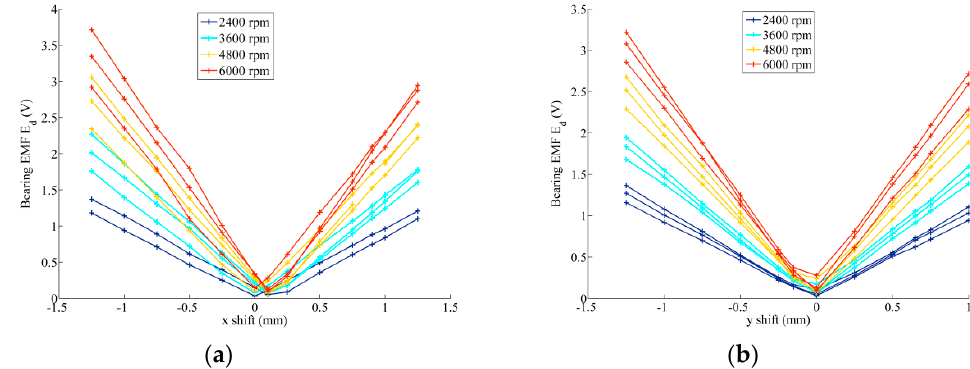
Figure 13. RMS values of bearing electromotive force E d for each phase as a function of the rotor position ( a ) in the x axis and ( b ) in the y axis for spin speeds of 2400, 3600, 4800, and 6000 rpm.